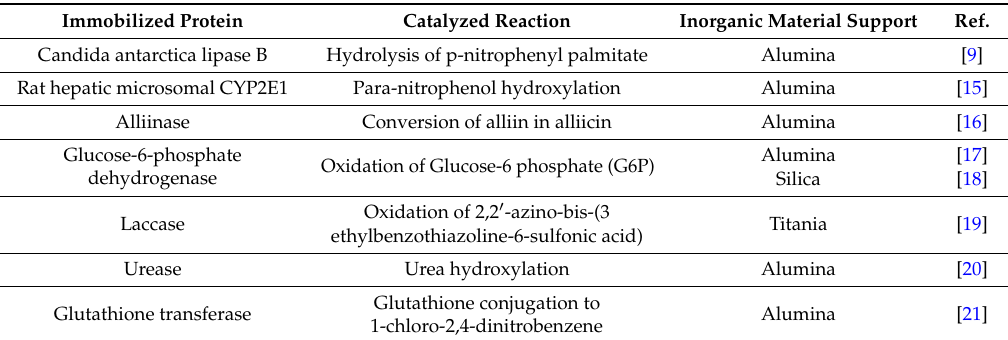
Table 1. Examples of BMRs using inorganic